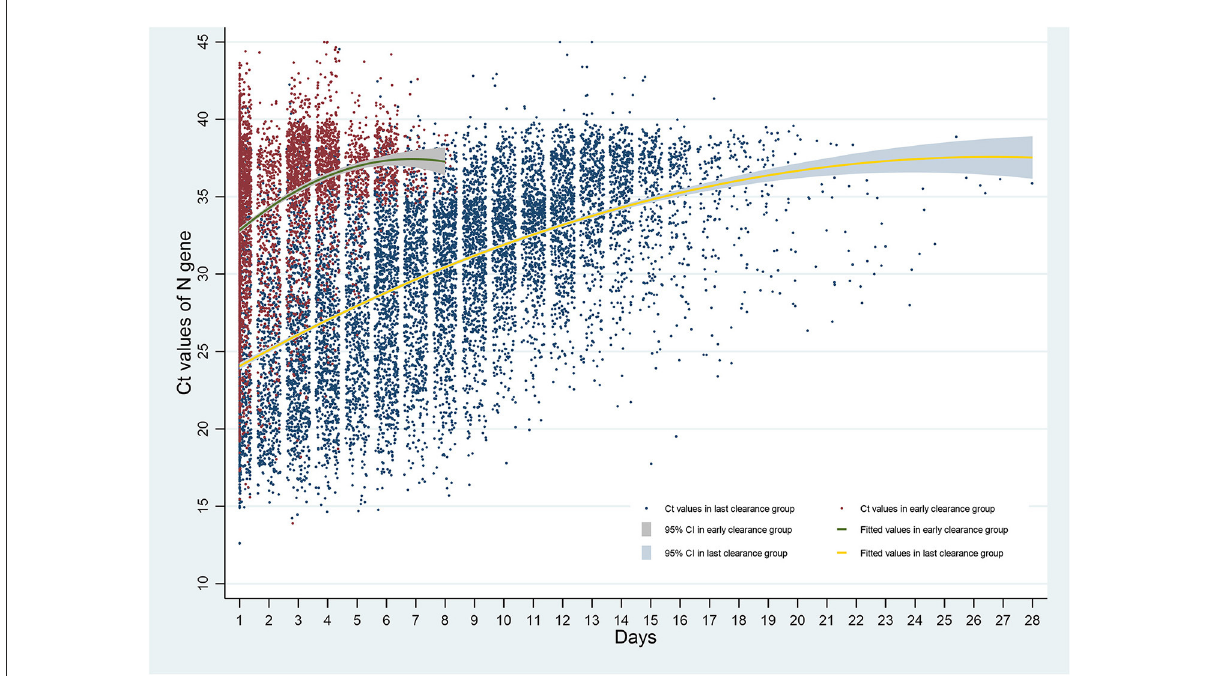
FIGURE5 Ct values of N gene over time after admission. Ct, cycle threshold; N gene, nucleocapsid protein